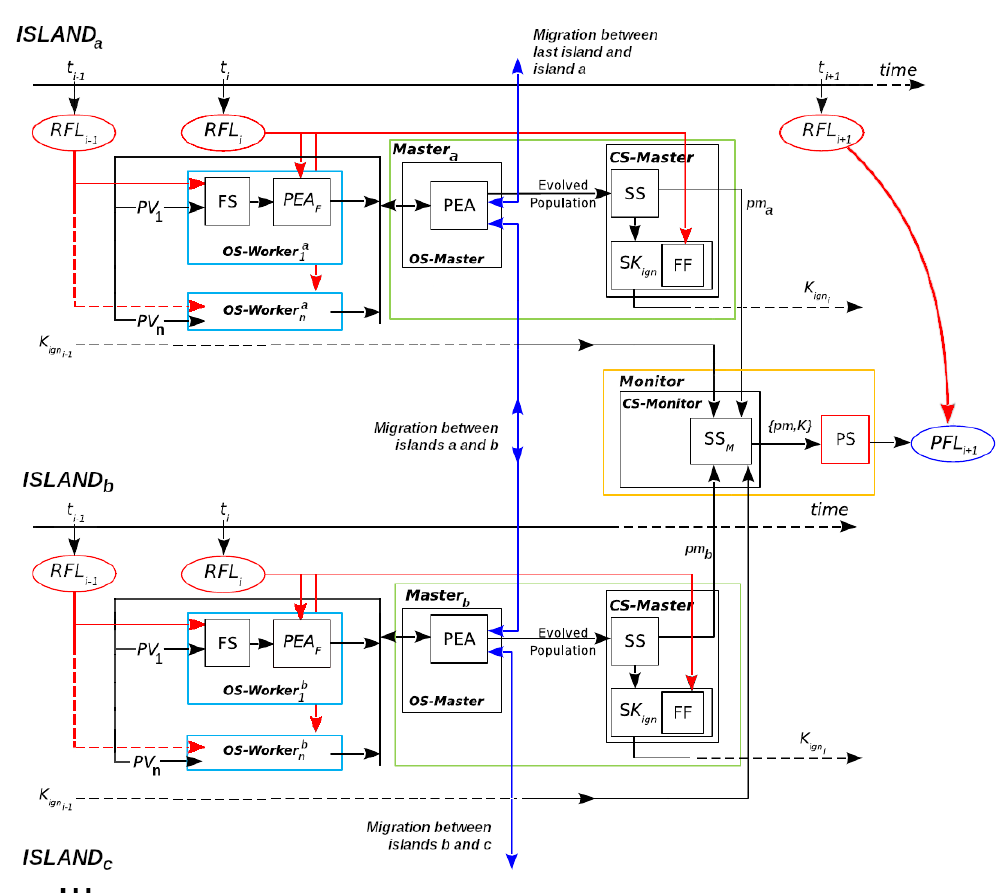
Figure 4. Evolutionary Statistical System with Island Model. RFL i : Real Fire Line at time t i ; PV { 1 ... n }